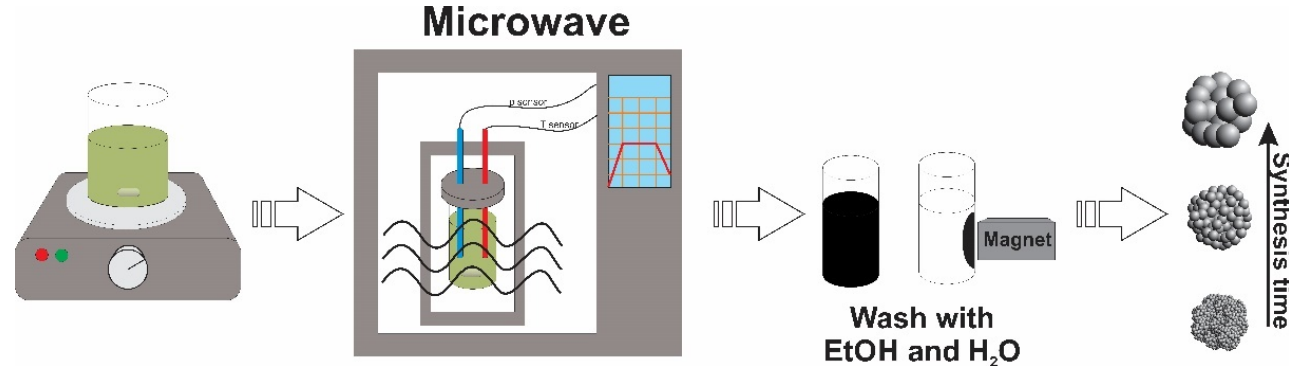
Figure 1. Synthesis scheme of Fe 3 O 4 submicron spheres.